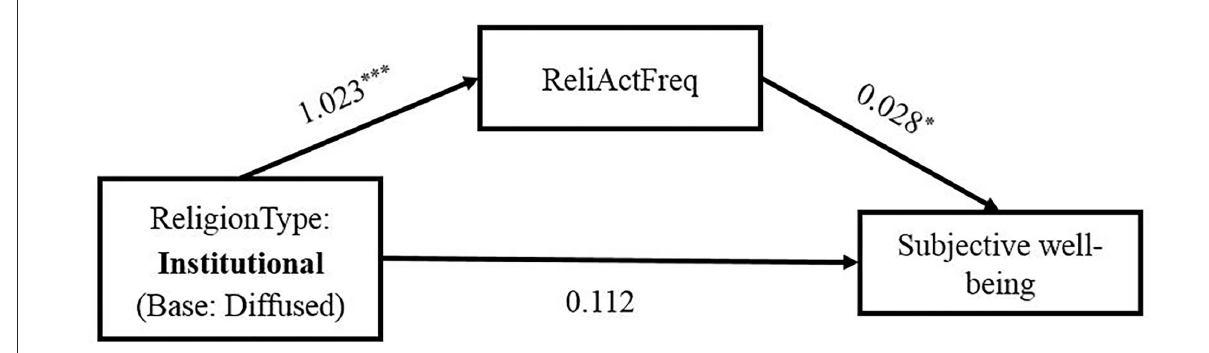
FIGURE1 The mediation model. ReliActFreq, religious activity frequency. * p < 0.05, ** p < 0.01, *** p < 0.001.